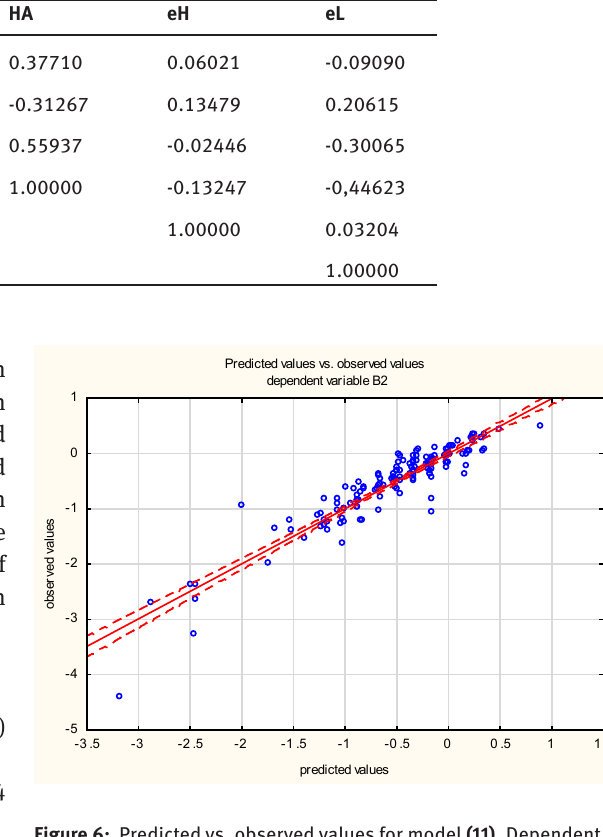
Figure 6: Predicted vs. observed values for model (11) . Dependent variable B2